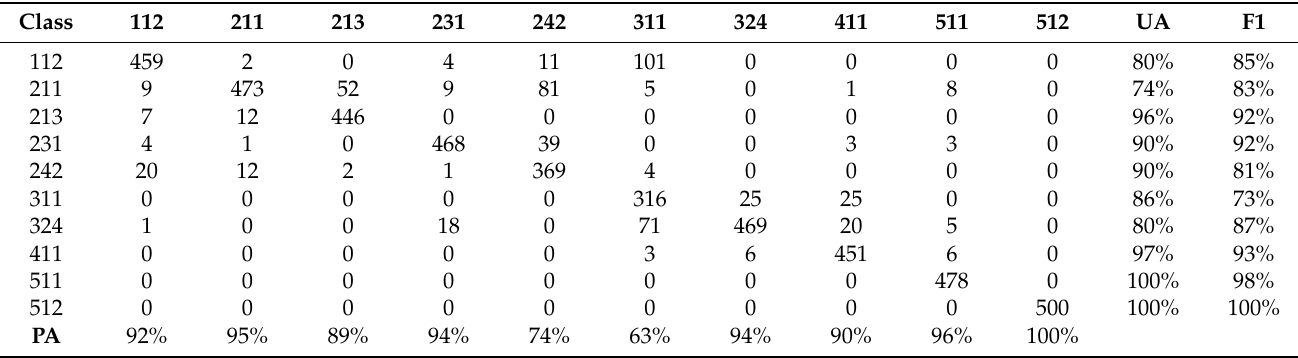
Figure 15. South Braila map based on Support Vector Machine, Radial Basis Function kernel classifier, Sentinel-2 images, Overall accuracy: 86%, Kappa coefficient 0.84. Table 6. Confusion matrix of the South Braila area (SVM RBF, Sentinel-2 images, OA: 86%, Kappa coefficient 0.84, UA—User Accuracy, PA—Producer Accuracy, F1-score).